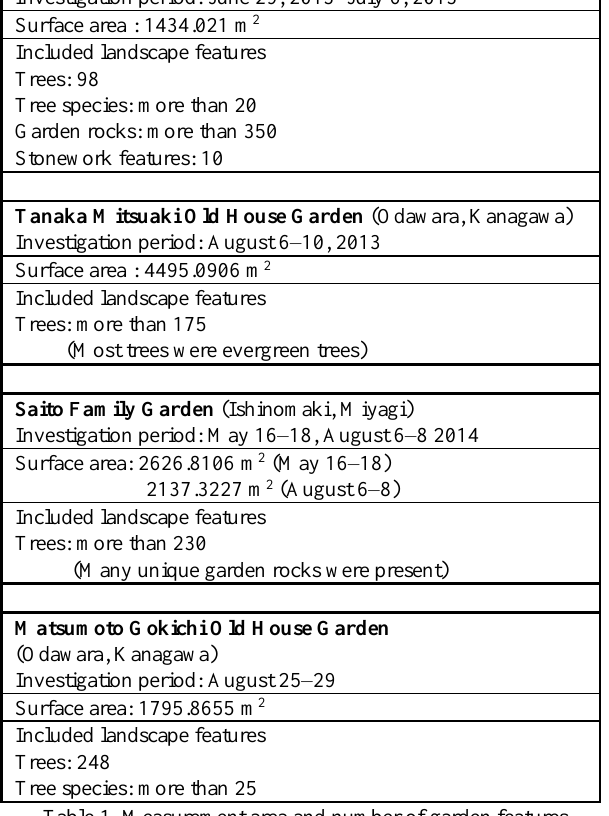
Table 1. Measurement area and number of garden features